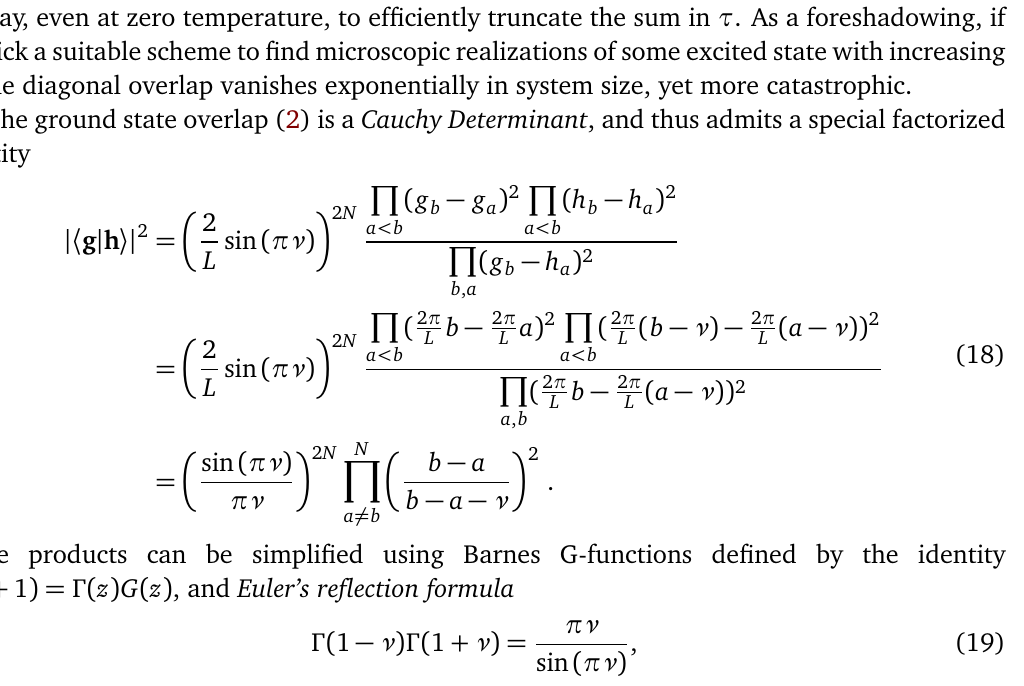
, h are the single particle a a